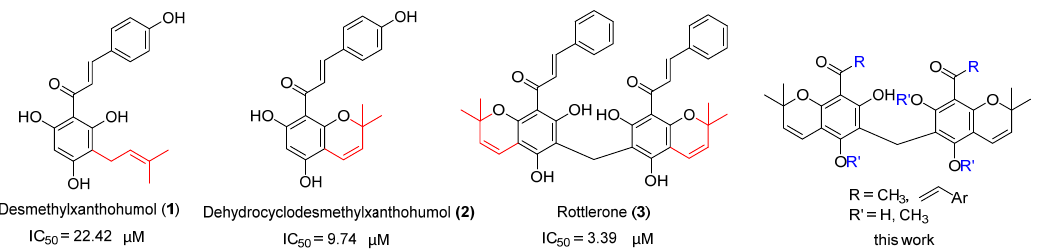
Figure 1. Structures of 1 – 3 and rottlerone analogues.